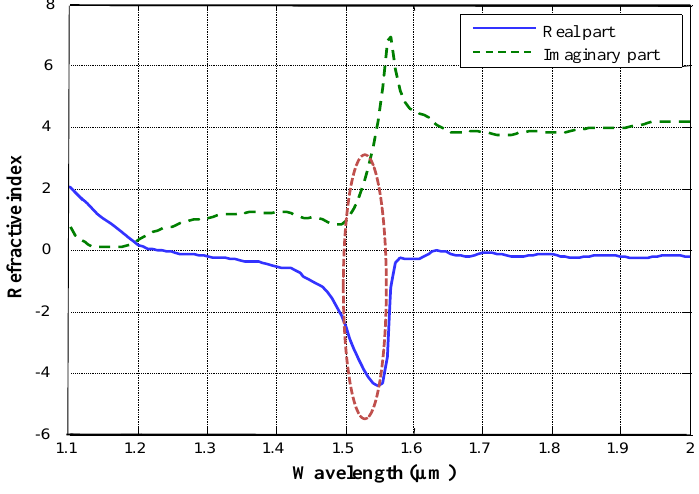
Figure 2. Simulated results for the real and imaginary part of the refractive index depicted by the blue and green curves respectively. The red dotted region highlights the high FOM